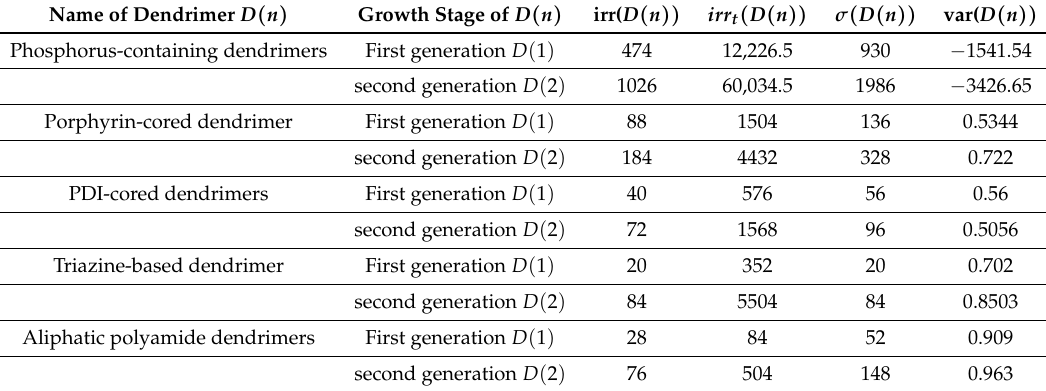
Table 1. The values of irregularity indices of dendrimers structures against first and second generation